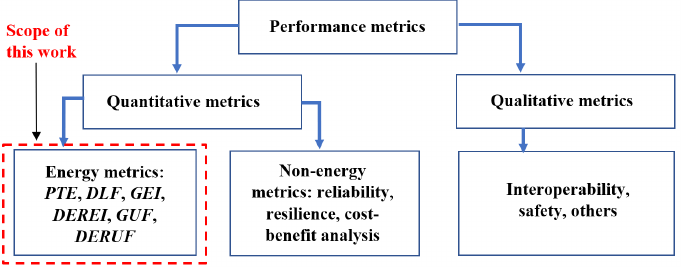
Figure 2. Performance metrics for building-level electrical distribution